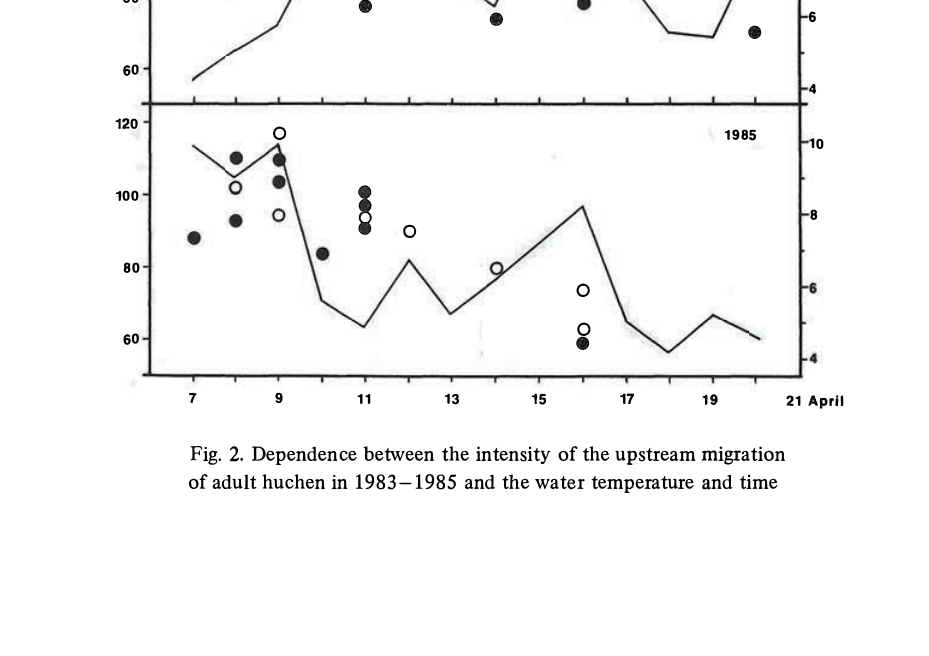
Fig. 2. Dependence between the intensity of the upstream migration of adult huchen in 1983-1985 and the water temperature and